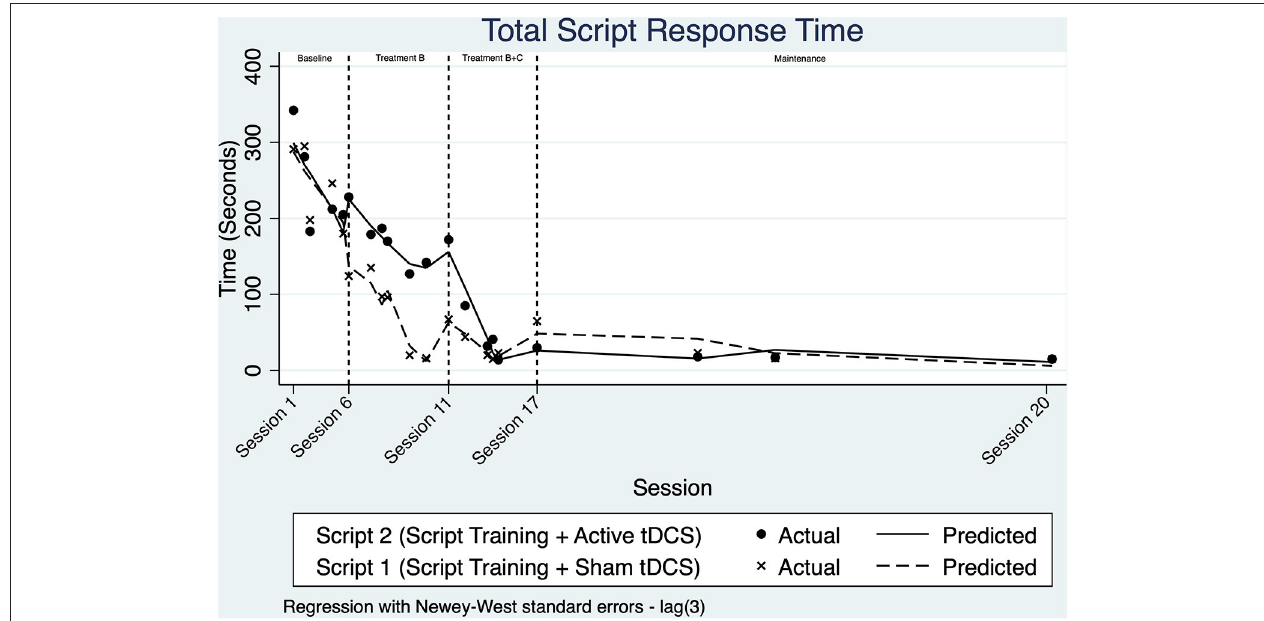
FIGURE 3 | Line chart of the change in total time (in seconds) required to complete script